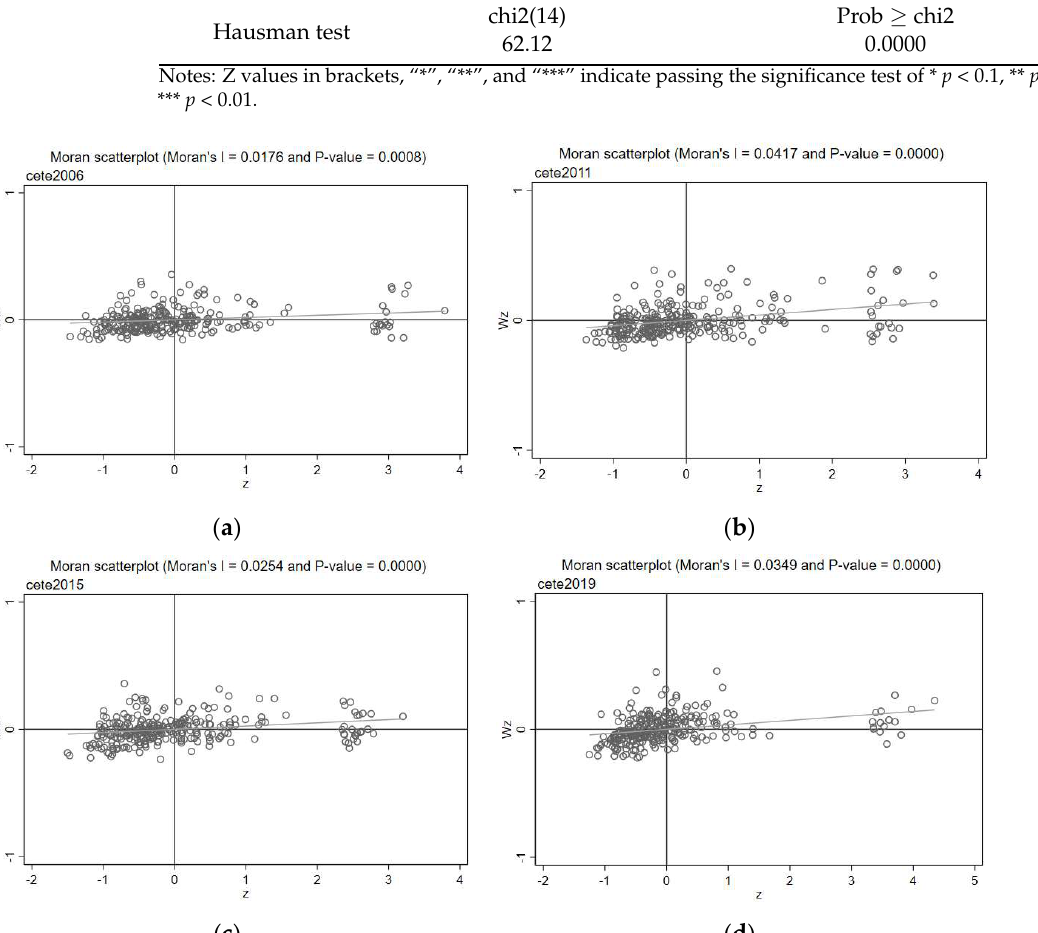
Table 3. Global Moran’s I of market segmentation, carbon performance, and model selection.